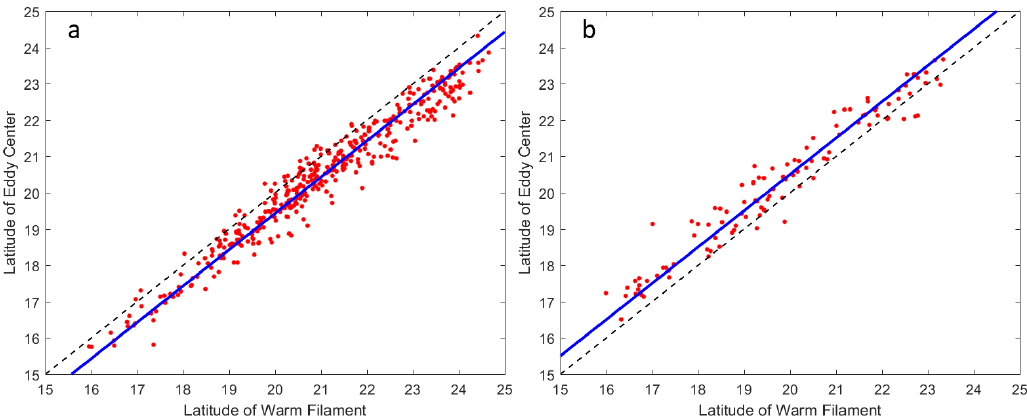
Figure 6. Eddy center position versus warm filament latitude for ( a ) the anticyclonic eddy case and ( b ) the cyclonic eddy case. The dashed line is the auxiliary line with slope of 1.